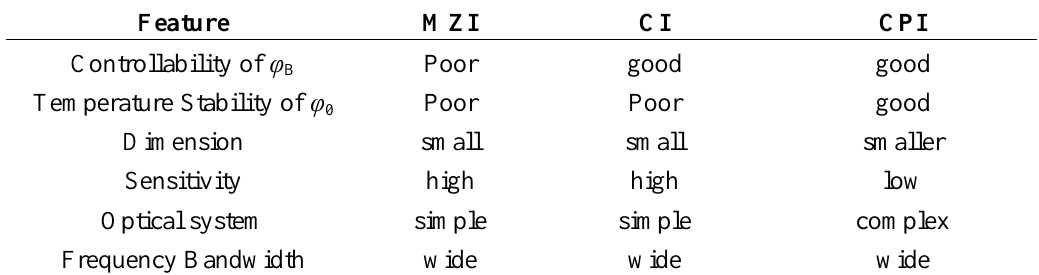
Table 2. Characteristics of the three types of